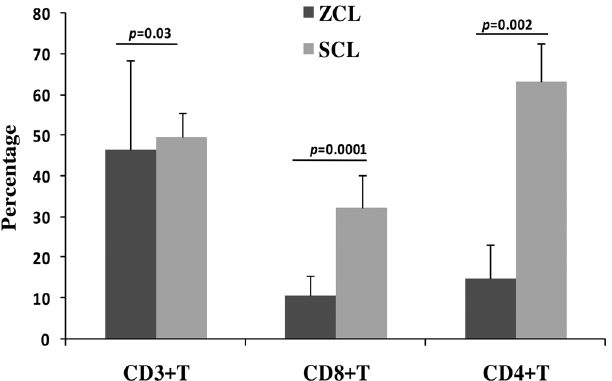
Figure 1. Proportions of CD3 + , CD4 + and CD8 + T cells within ZCL and SCL lesions. Histograms represent results of the immunohisto- chemical analysis expressed as a percentage of positively stained cells among mononuclear cells. Results are expressed as the mean plus the standard error of percentage mean. Any signi fi cance found is indicated by a bar on top of each graph connecting the two comparisons. p < 0.05 was considered statistically signi fi